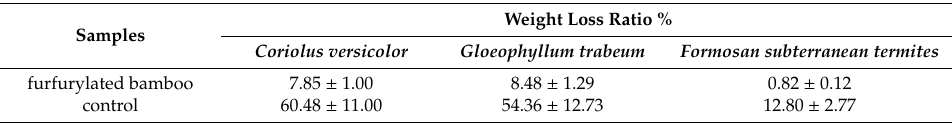
Table 4. The weight loss ratio of furfurylated bamboo after decay and Formosan subterranean termites